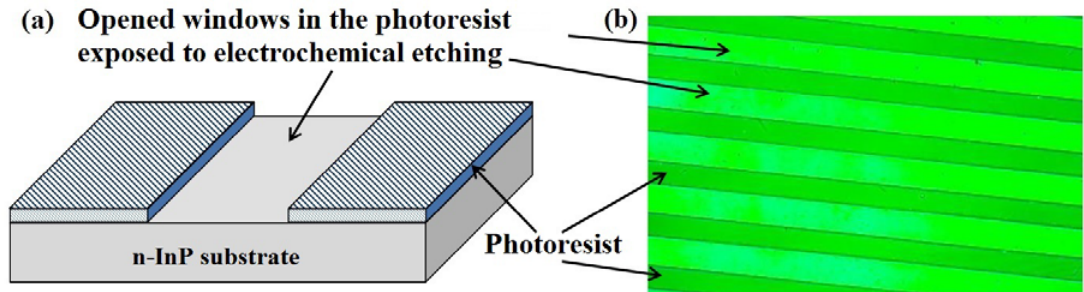
Figure 3. (a) Schematic representation of the “C” channel formation via anodization of the semiconductor substrate through opened window in the photoresist. (b) Optical image of developed photoresist after exposure with UV light. The image is from InP